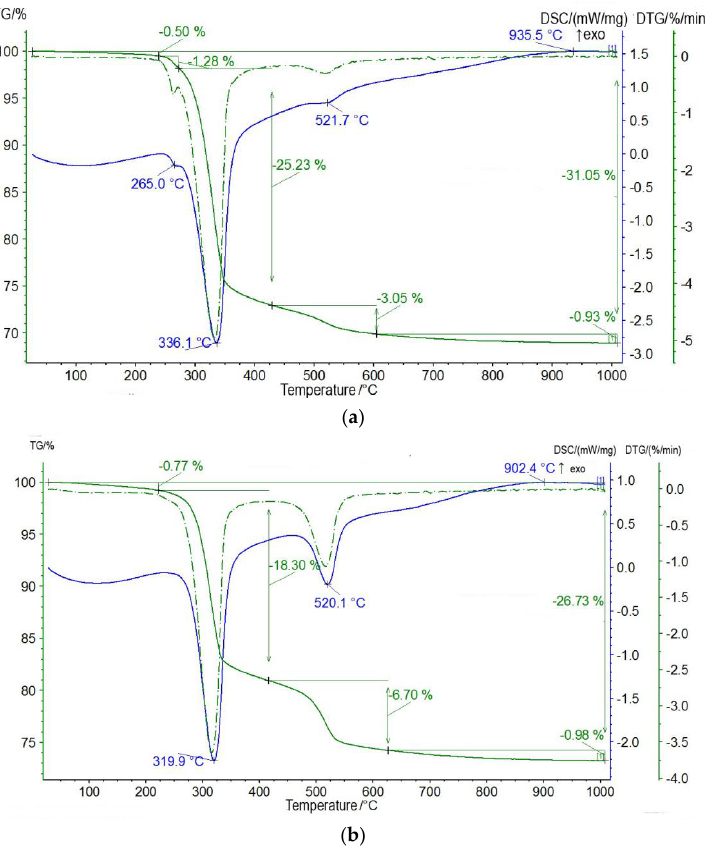
Figure 5. Thermal curves: ( a ) gibbsite; ( b ) gibbsite and boehmite.